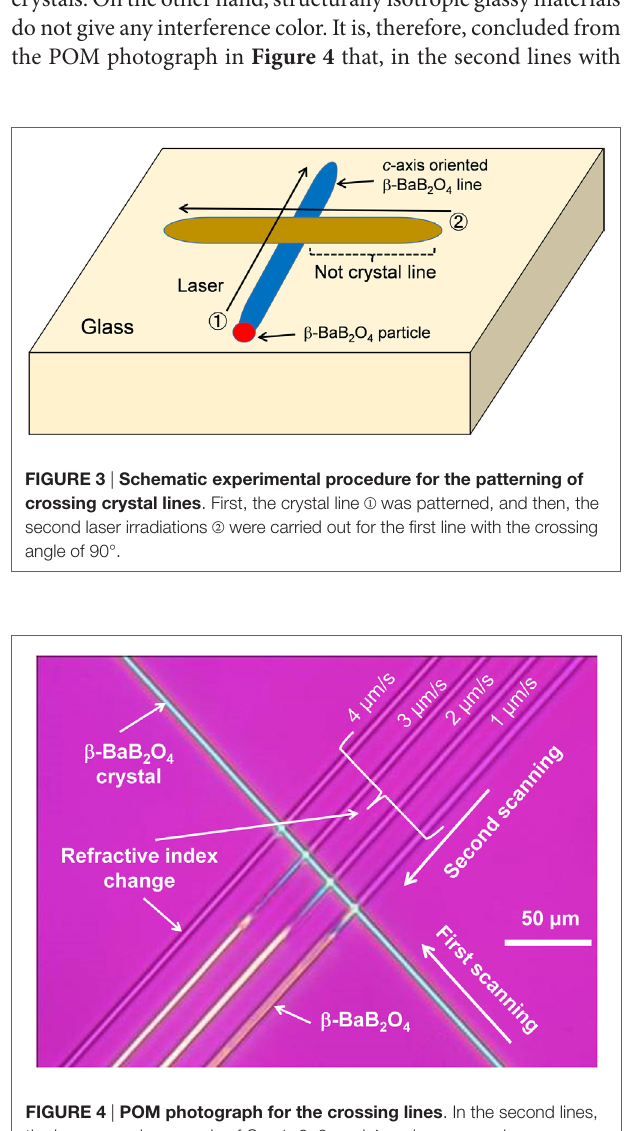
FigUre 4 | POM photograph for the crossing lines . In the second lines, the laser scanning speeds of S = 1, 2, 3, and 4 μ m/s were used.